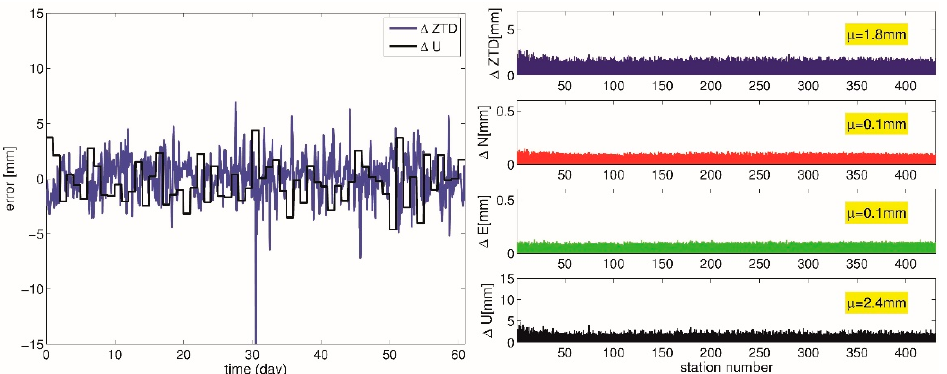
Figure 5. Results for the fourth simulation experiment. Left panel: the error in the ZTD and the error in the station up-component for the station POTS as a function of time. Right panel: the station- specific RMSE for the ZTD (top), the gradient components (middle), and the station up-component (bottom). The number with yellow background corresponds to the averaged RMSE of the respective parameter.